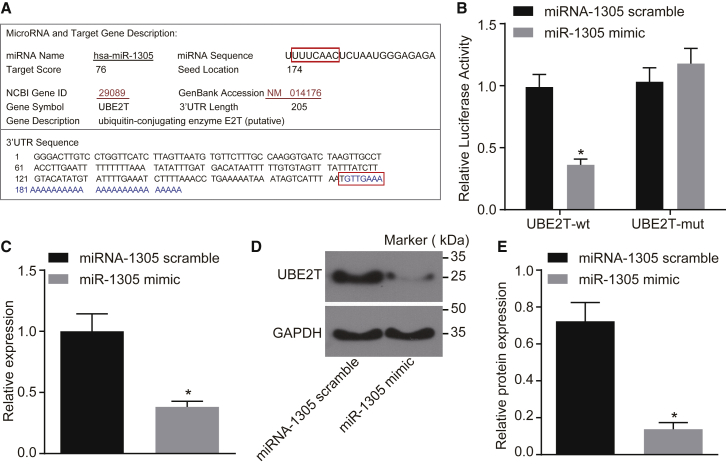
UBE2T Was a Target Gene of miR-1305(A) The predictive binding site between miR-1305 and UBE2T 3′ UTR. (B) Dual luciferase reporter gene assay for confirmation of the targeting relationship between miR-1305 and UBE2T. (C) The mRNA expression of UBE2T in the presence of miR-1305 mimic, determined by qRT-PCR. (D) The gray value of the UBE2T protein band in the presence of miR-1305 mimic determined by western blot analysis. (E) The protein expression of UBE2T in the presence of miR-1305 mimic, determined by western blot analysis. miR-1305 scramble group, LCSCs transfected with scramble miR-1305; miR-1305 mimic group, LCSCs transfected with miR-1305 mimic. *p < 0.05 versus LCSCs transfected with scramble miR-1305. Statistical data were described as mean ± SD. Data between two groups were analyzed by unpaired t test. The experiment was repeated 3 times independently.